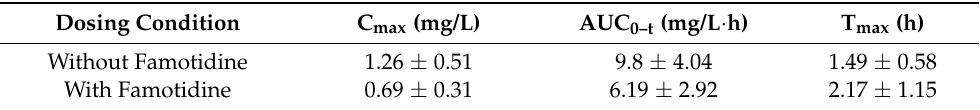
Table 5. Simulated PK parameters (arithmetic means ± SD) of model compound following